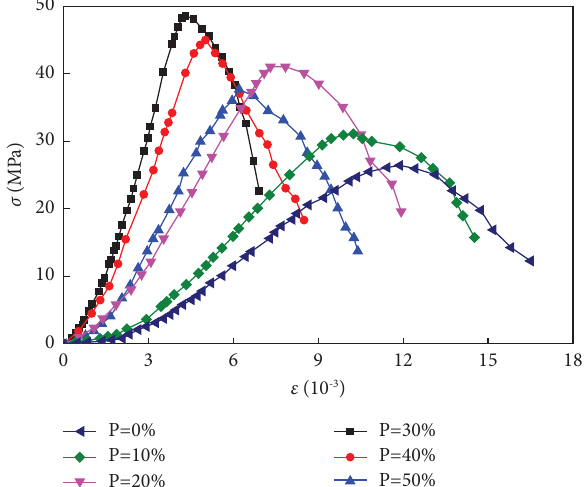
Figure 7: Stress-strain curves of fy ash concrete with diferent contents.